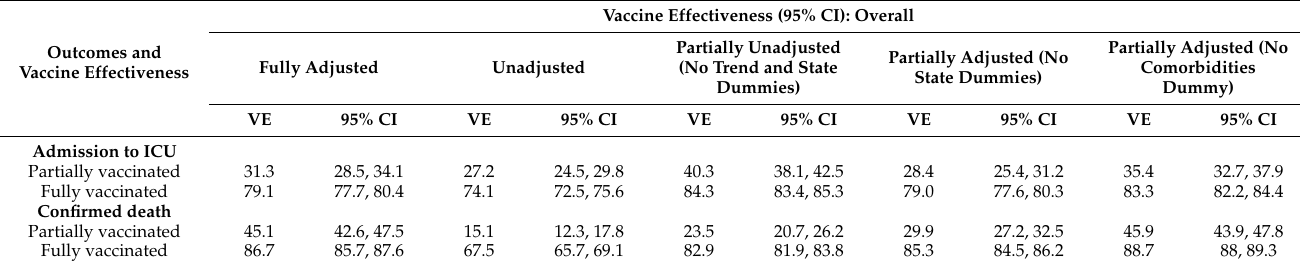
Table A2. Fully adjusted, partially adjusted, and unadjusted vaccine effectiveness in preventing admission to ICU and deaths among COVID-19 cases, according to vaccination status with any of AZD1222, BNT162b2, or CoronaVac.